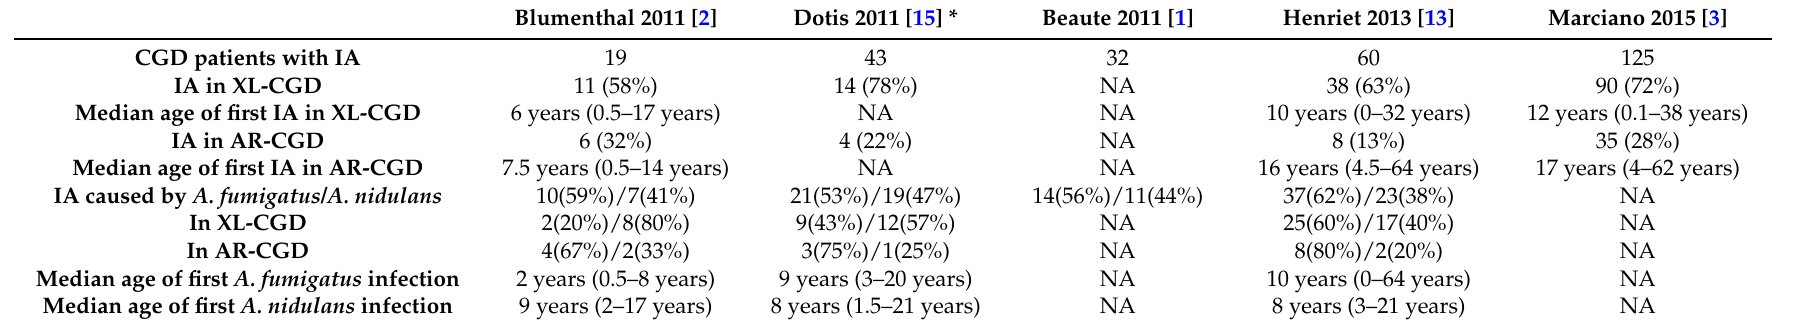
Table 1. Clinical epidemiology of invasive aspergillosis caused by A. fumigatus and A. nidulans in chronic granulomatous disease